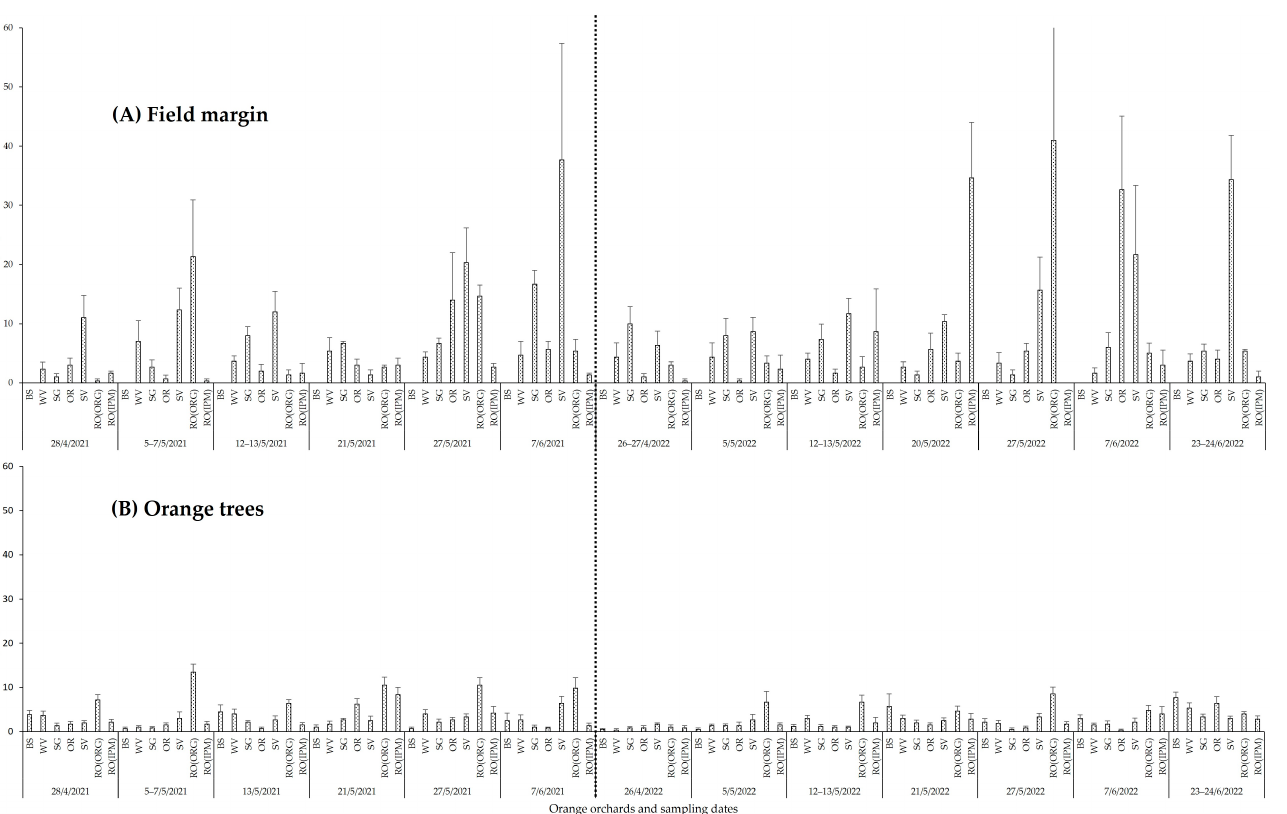
Figure 6. Temporal distribution of Hymenoptera parasitoids ( A ) in field margins and ( B ) on orange trees in orchards with different field margin management: BS—bare soil; WV—weed vegetation; RO(ORG)—rosemary hedgerow (organic orchard); RO(IPM)—rosemary hedgerow (IPM orchard); OR—oregano hedgerow; SG—sage hedgerow; SV—savory hedgerow.